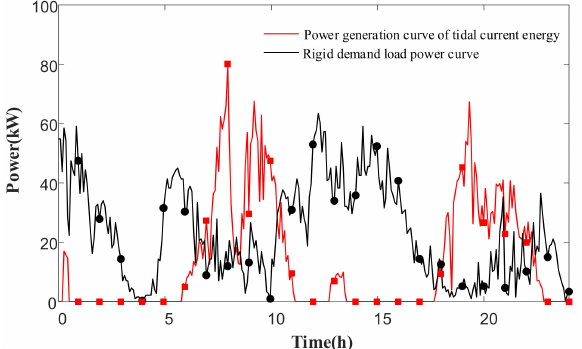
Figure 11. A 24-h curve of real-time tidal current energy generation output and island load.